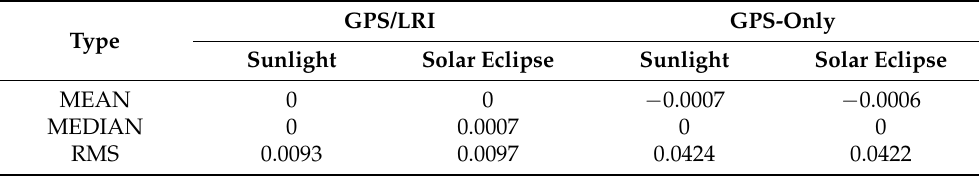
Table 12. Statistics of KBR residual (unit: m, days 121–242) in Sunlight and Solar eclipse.